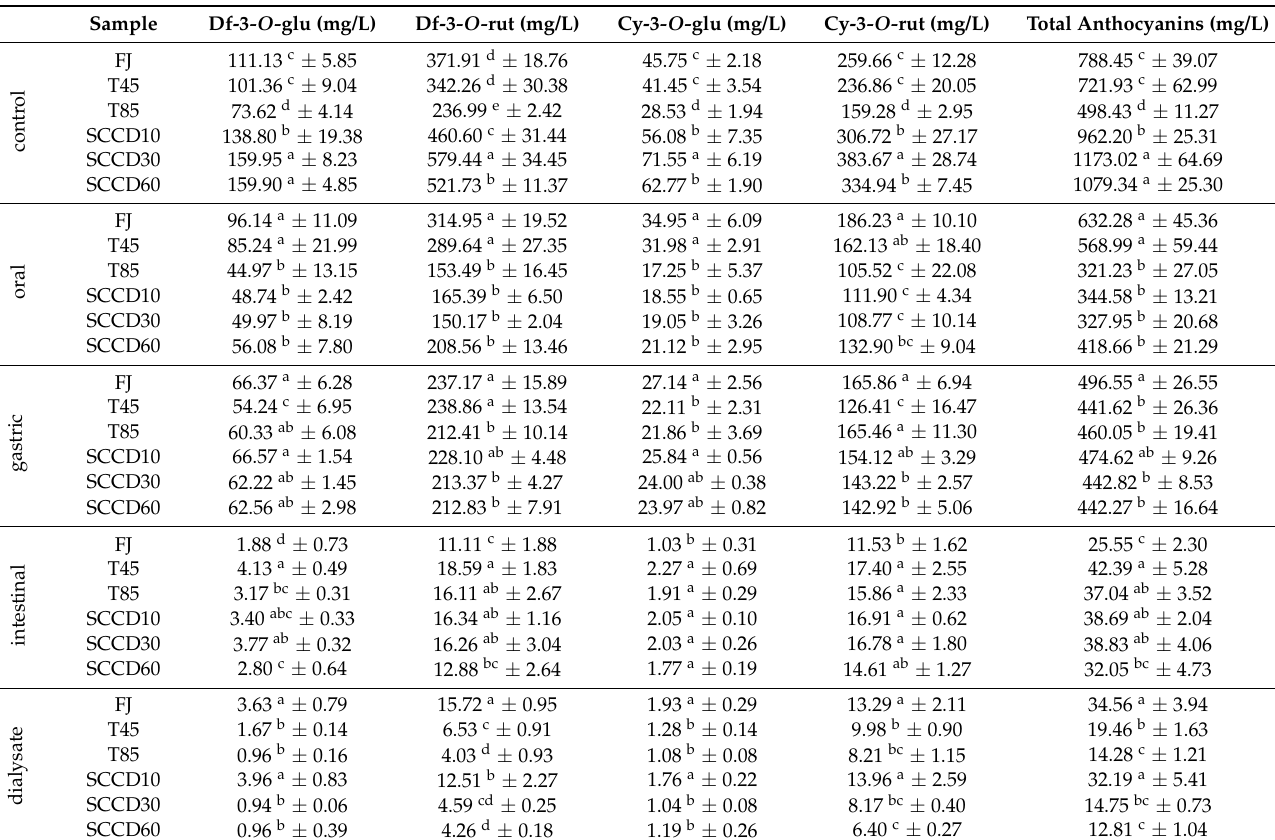
Table 2. Total anthocyanin content at each stage of digestion of blackcurrant